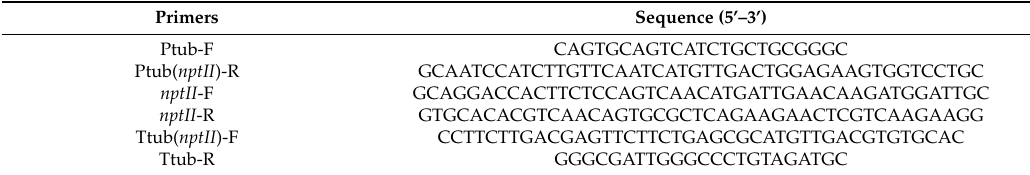
Table 2. Primers prepared for construction of pEASY- tub- nptII via fusion PCR.